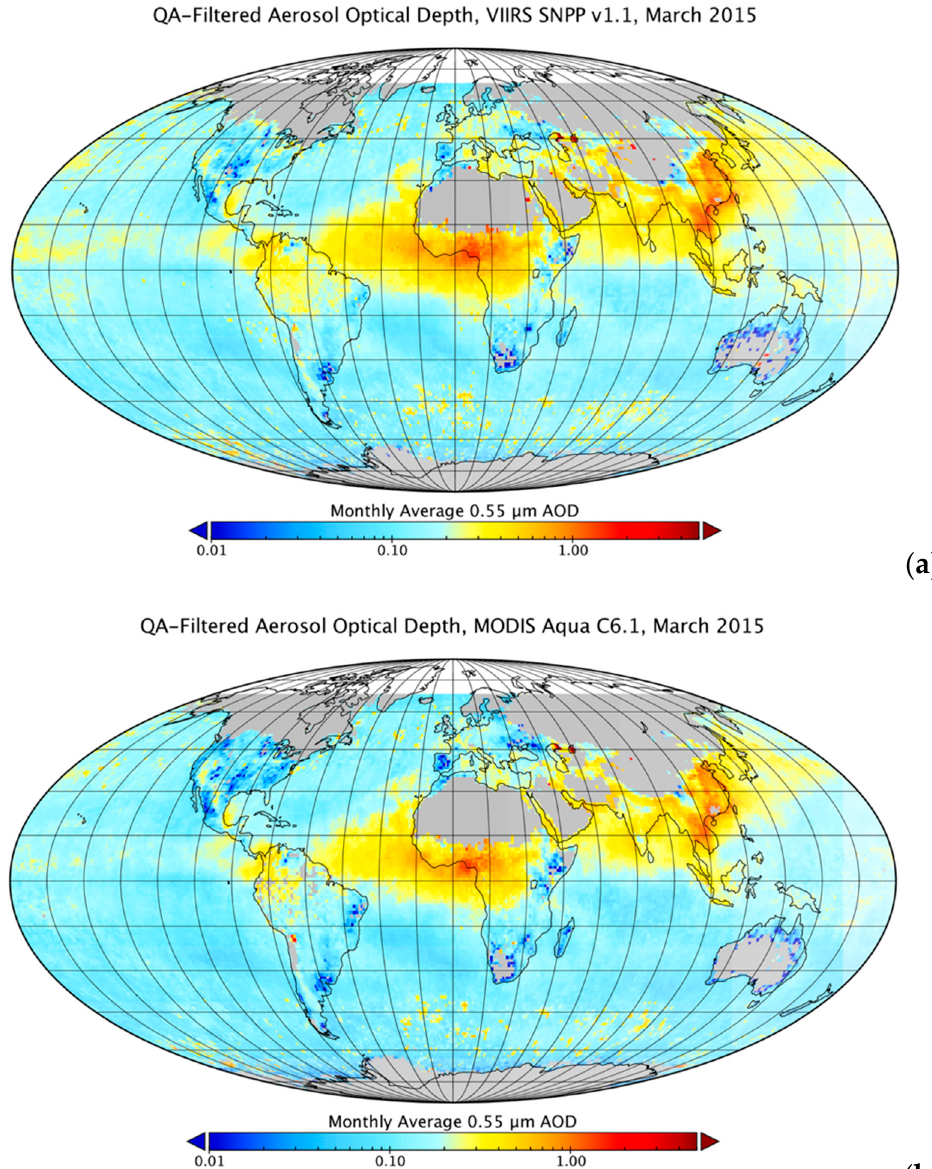
Figure 10. Monthly average QA-filtered 0.55 µ m AOD for March 2015, from ( a ) VIIRS and ( b ) MODIS. The global mean AOD values are 0.20 and 0.17, respectively.